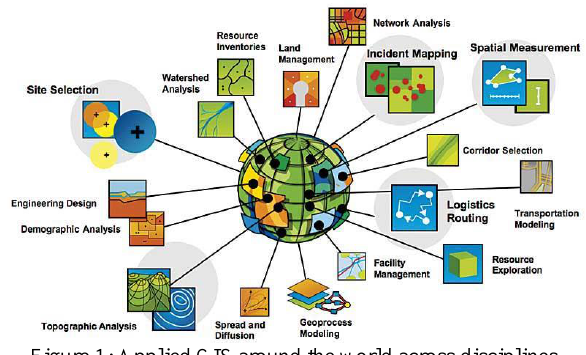
Figure 1: Applied GIS around the world across disciplines, professions and organizations (ESRI, 2007).